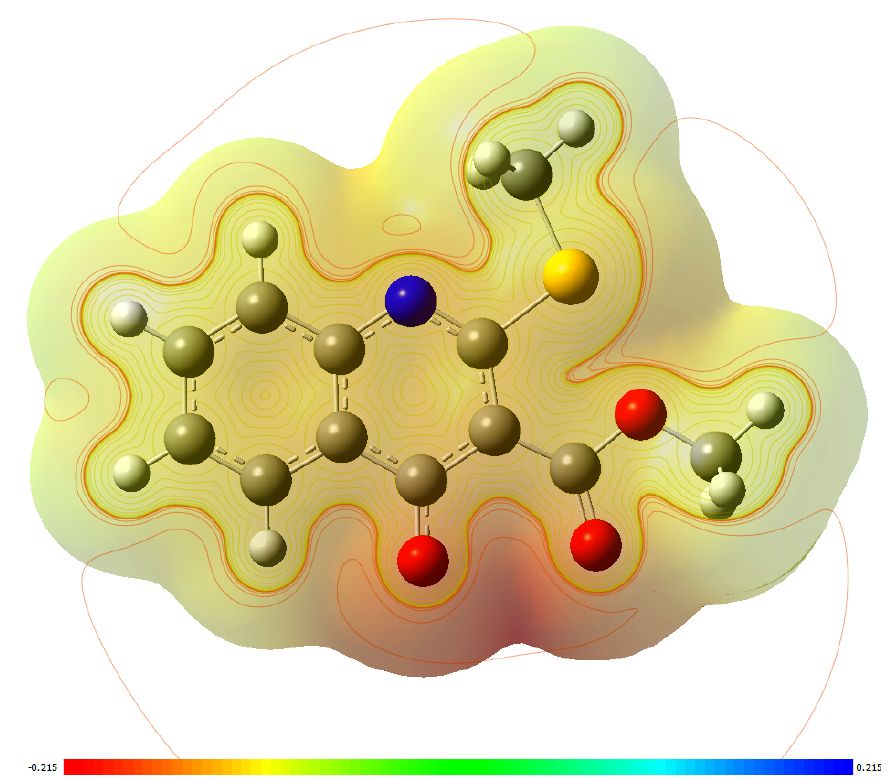
Figure 2. Visualization of the total electrostatic potential map of anion 3 (red regions corresponds to negative charge).